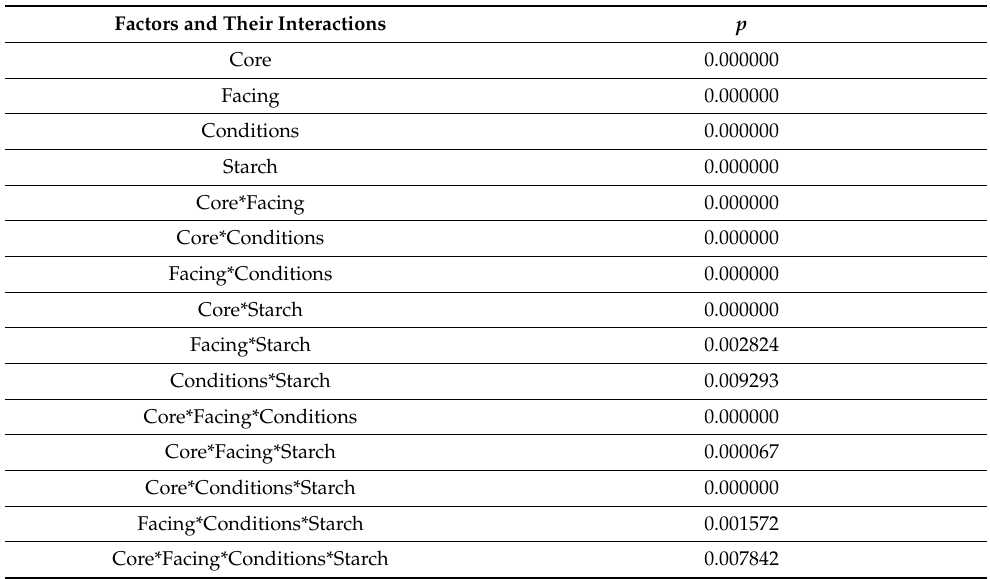
Table 8. Statistical significance for the model in the multidirectional classification takes into account the X orthotropy direction.